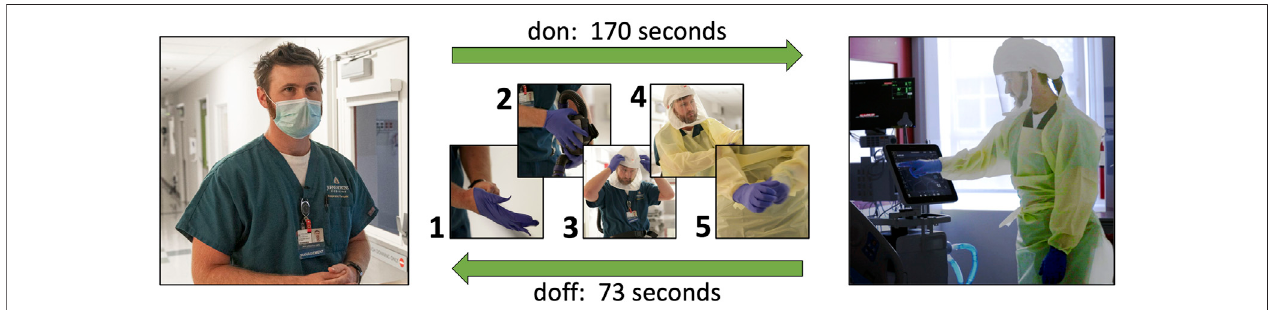
FIGURE 9 | During our qualitative system evaluation in the biocontainment unit of the Johns Hopkins Hospital, it took 170 s for a respiratory therapist to don his personal protective equipment (1: a pair of disposable nitrile gloves, 2: respirator device, 3: mask, 4: plastic gown, 5: a second pair of disposable nitrile gloves) and 73 s for dof fi